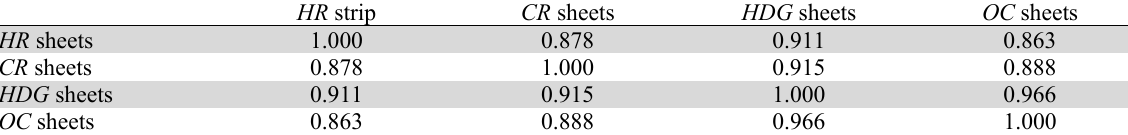
Correlation matrix for the apparent consumption of metallurgical products manufactured by the analyzed company